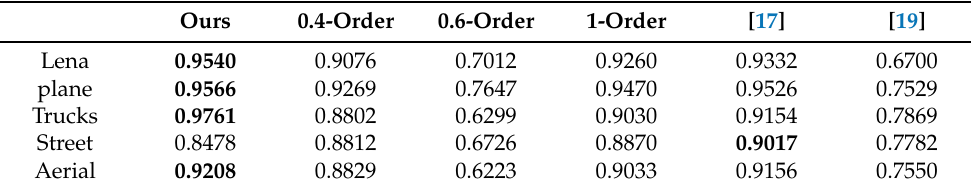
Table 1. Under different algorithms, the Structural Similarity Index Measure ( SSIM ) values of different images.